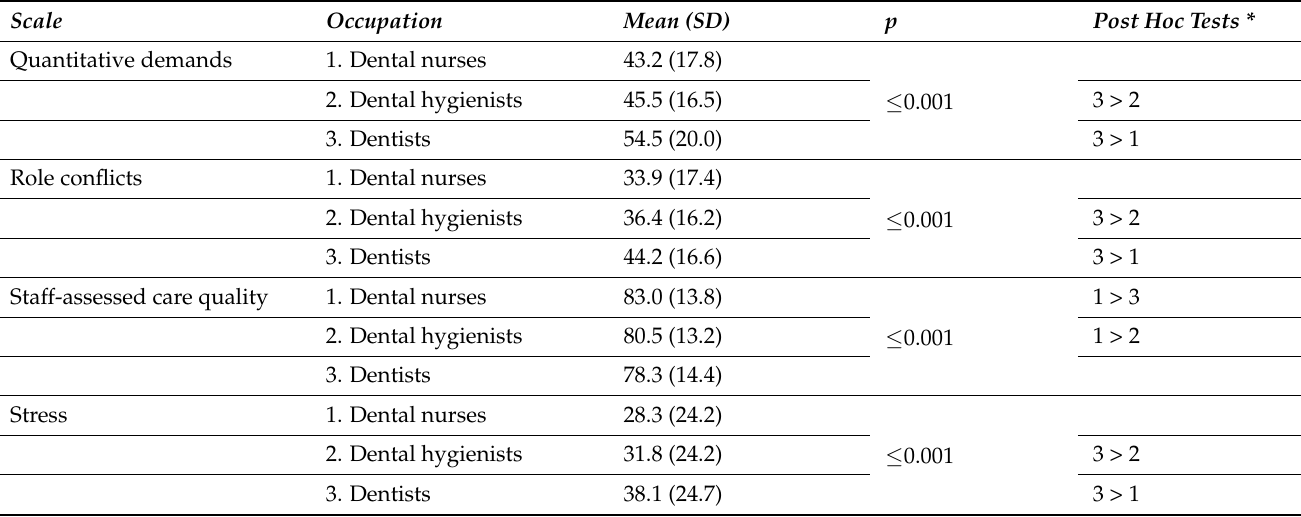
Table 2. Mean, standard deviations (SD) for study variables based on occupational group.